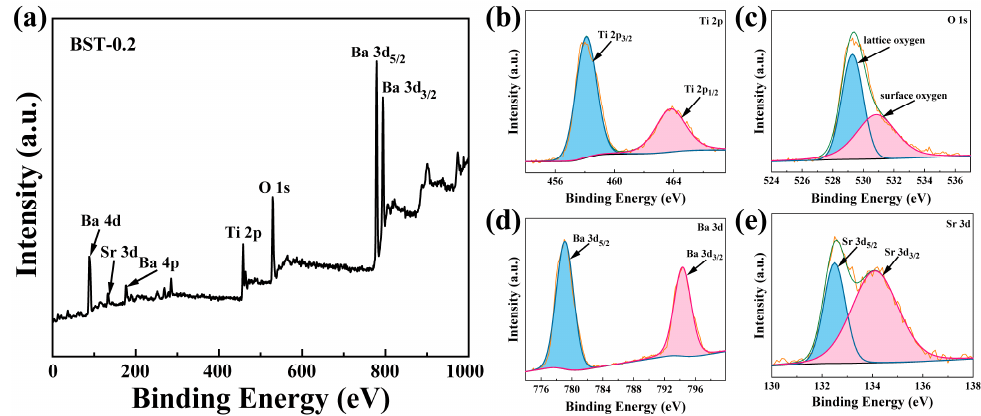
Figure 3. XPS spectra of BST-0.2 nanopowders: ( a ) XPS survey spectrum; ( b ) Ti 2p; ( c ) O 1s; ( d ) Ba 3d; ( e ) Sr 3d.